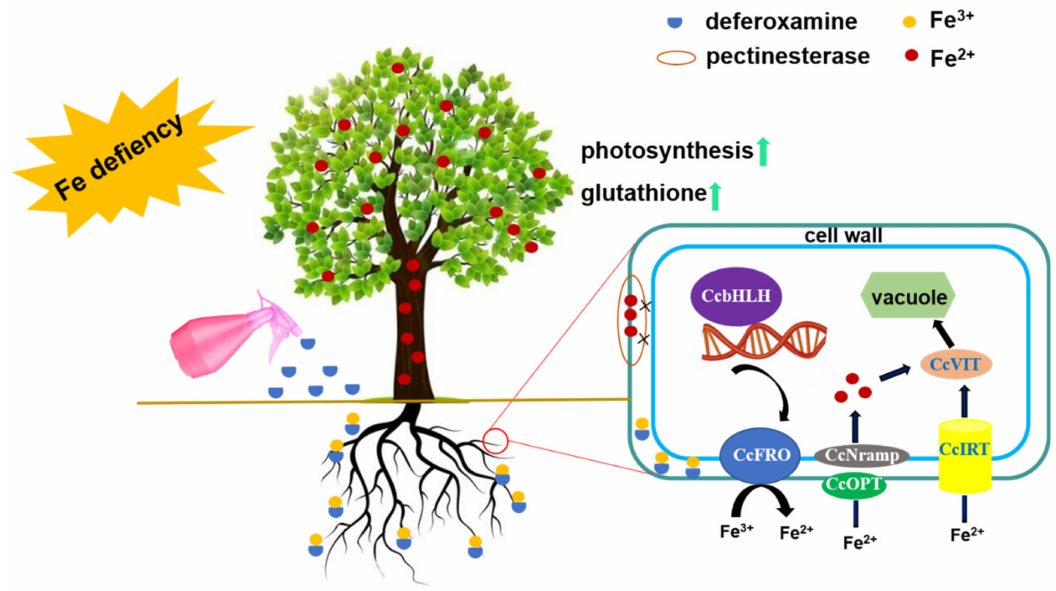
Figure 8. A schematic model for deferoxamine-alleviated iron deficiency in C. camphora plants. Supplemental DFO combined with insoluble Fe 3+ in the soil form a complex. On the one hand, the root of C. camphora reduces Fe 3+ in the complex to Fe 2+ by CcFRO and then transports it to the nucleus by CcNramp , CcOPT and CcIRT . On the other hand, DFO improves the photosynthetic efficiency